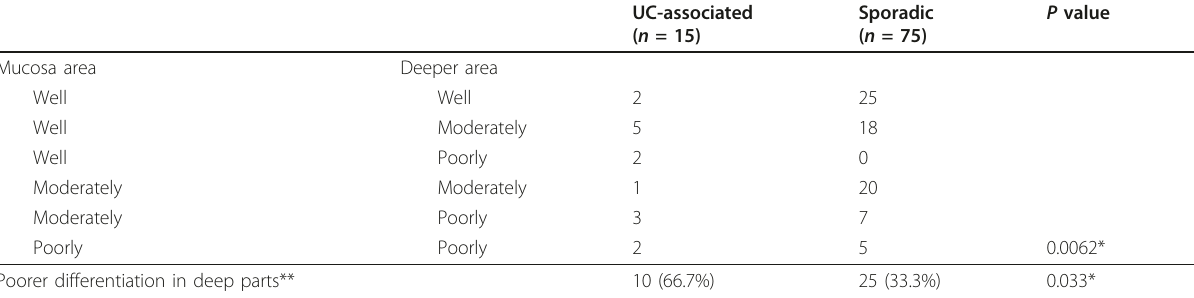
Table 3 Comparison of histologic type between mucosa and deeper parts (submucosa or deeper) of cancer